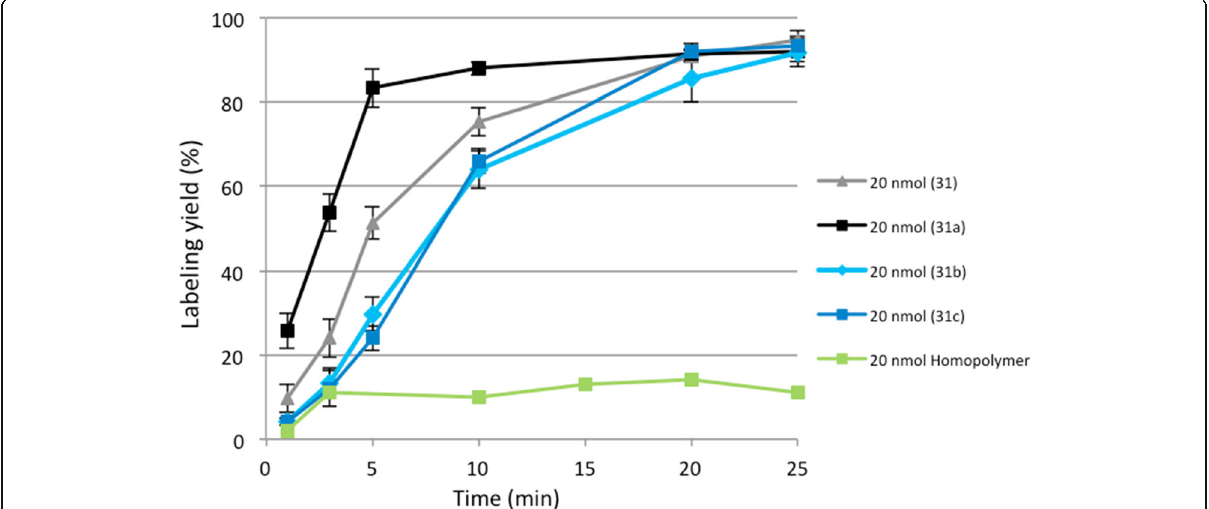
Fig. 4 Radiolabeling yield of conjugates 31 with different amounts of DOTA utilizing acetone post-processed gallium-68 (20 nmol; 25 min; 95 °C; n